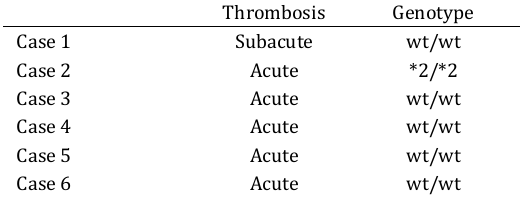
Table4. Genotype of patients with stent thrombosis Thrombosis Genotype